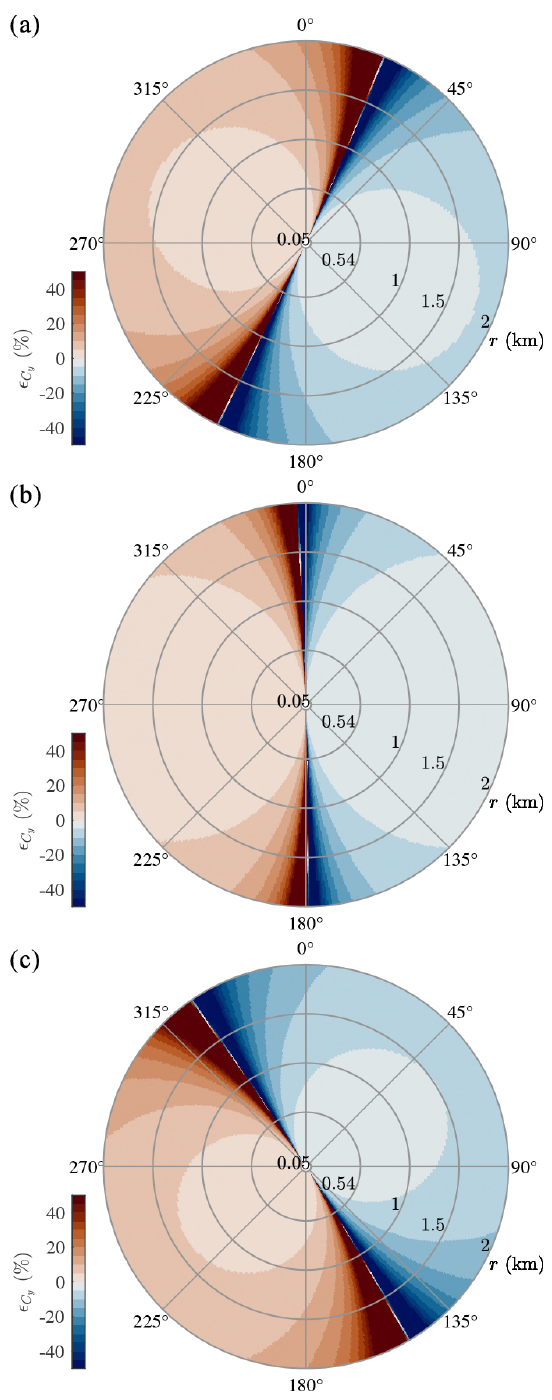
Figure 9. Relative error (cid:15) C on the Davenport decay coefficient C y y between LidarN and LidarW (a) , LidarN and LidarS (b) , and Li- darW and LidarS (c) , assuming an azimuth offset of − 0 . 1 ◦ for one of the two lidars selected. This relative error is independent on the value of C y . The colour map was taken from Crameri